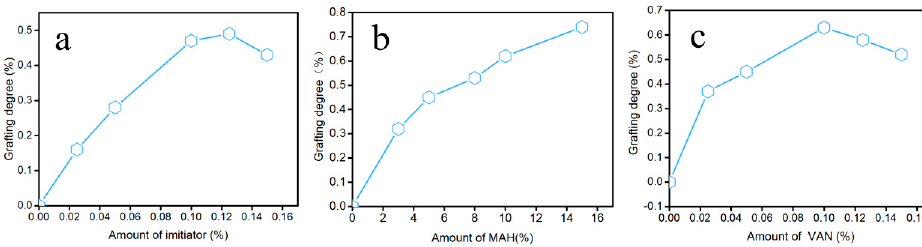
Figure 3. Effect of initiator concentration ( a ), MAH concentration ( b ) and VAN concentration ( c ) on grafting degree.